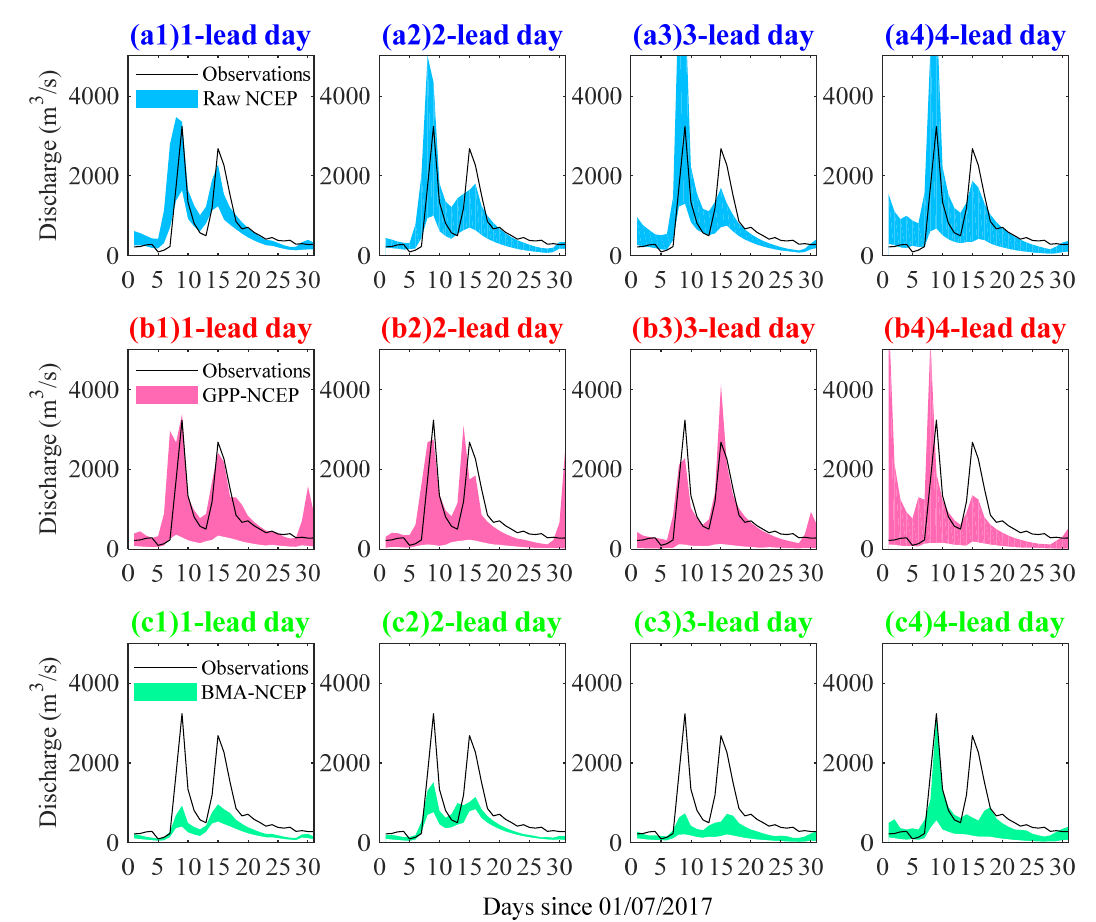
Figure 10. Hydrographs of ensemble streamflow simulated by XAJ model using raw and postpro- cessed EPFs from ECMWF as inputs at 1, 2, 3, and 4 lead days, compared with observed streamflow. The shaded area represents the 5th–95th percentile values driving by 1000 postprocessed ensembles.